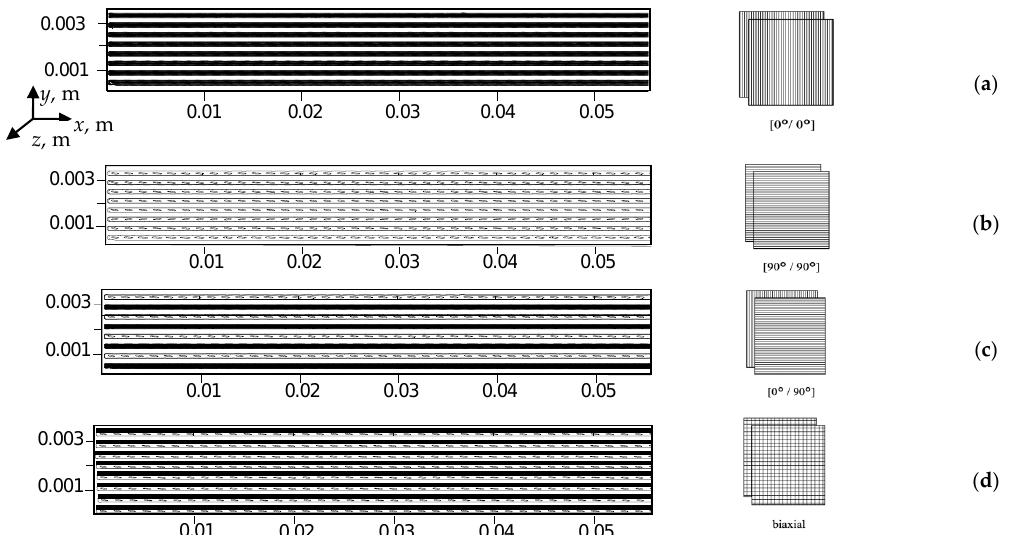
Figure 10. Computational schemes corresponding to different CF layouts: ( a )—(0°/0°); ( b )—(90°/90°); ( c )—(0°/90°); ( d )—(biaxial).